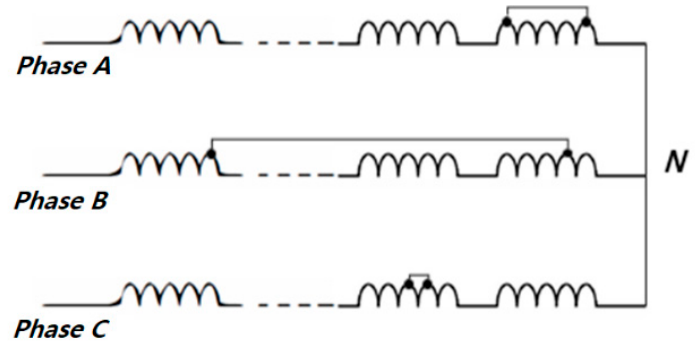
Figure 1. Short circuit in slots.